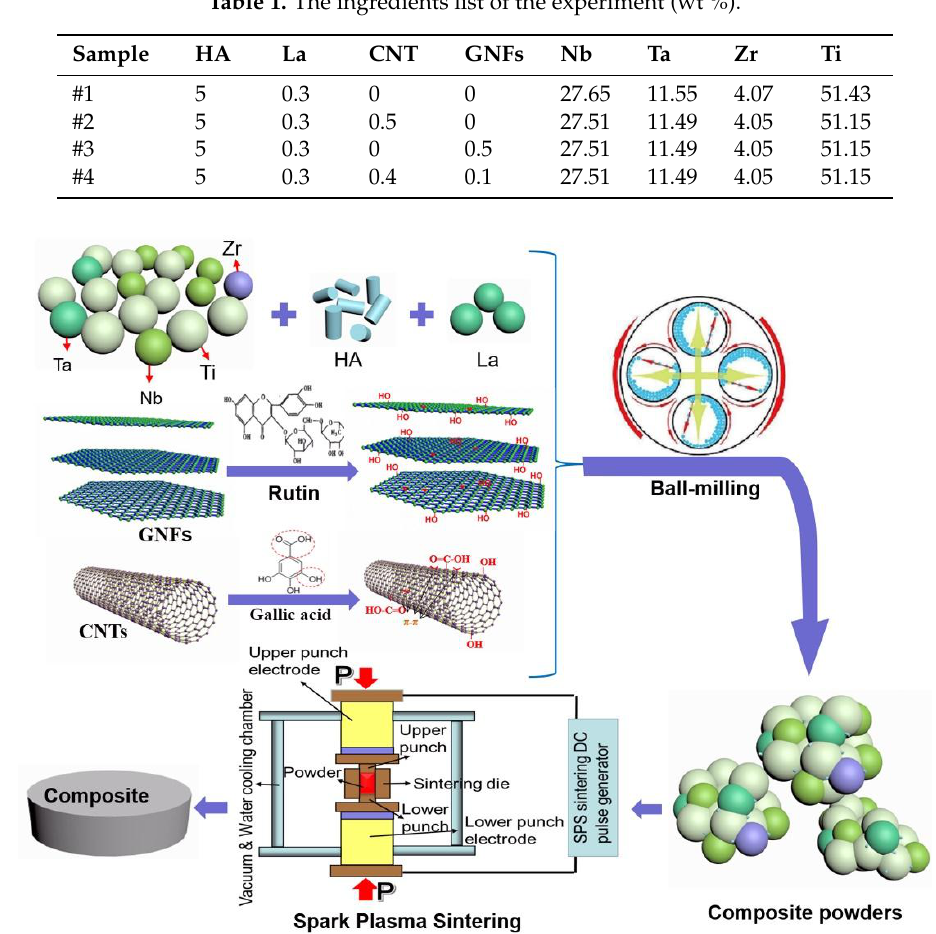
Figure 1. The schematic diagram of the experiment.